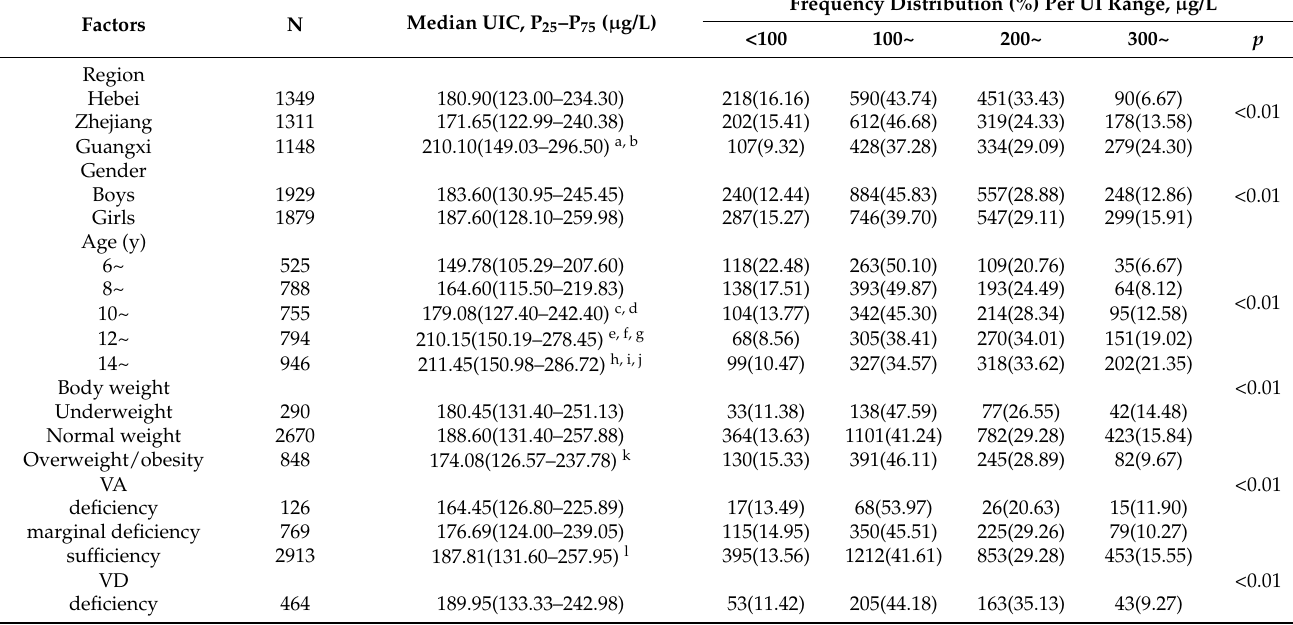
Table 2. Median and frequency distribution of UI among Chinese school-age